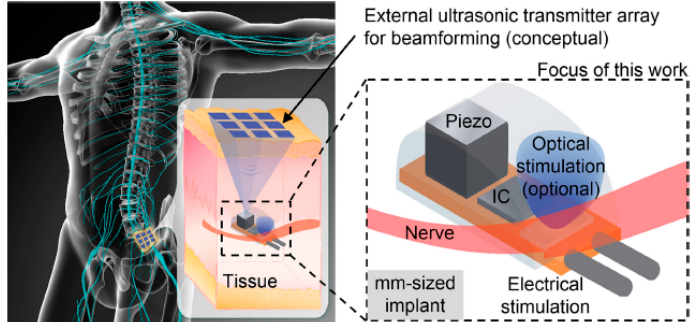
Figure 50. Conceptual diagram of the proposed electrical stimulation implant [205]. Copyright © 2018, IEEE.